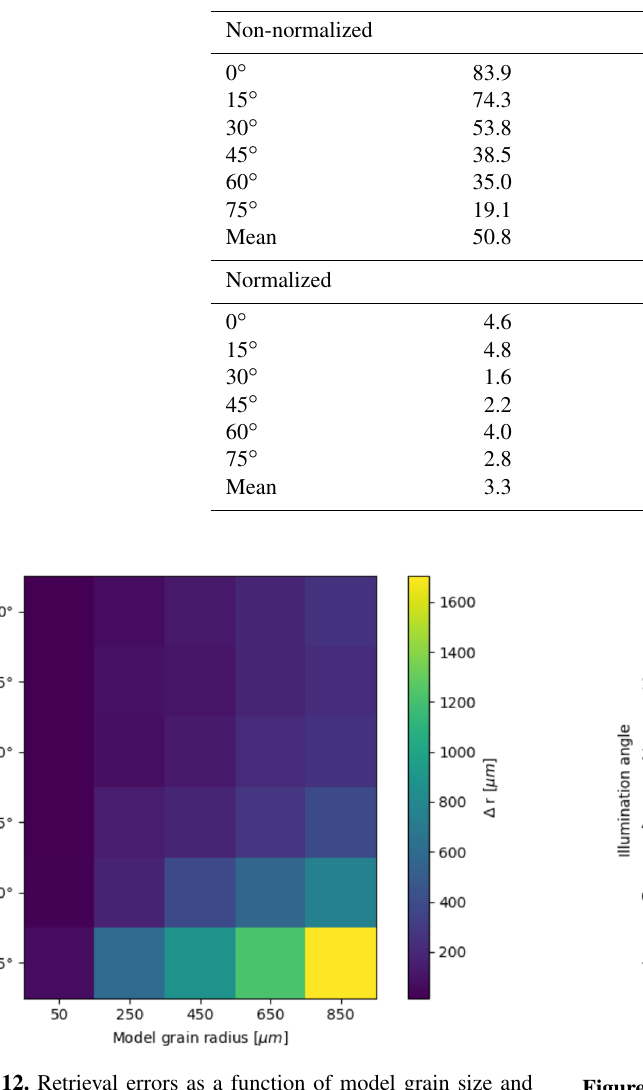
Table 1. Root mean square errors of retrieved snow grain size using non-normalized band area (top half) and normalized band area (bottom half). In the header, ”Calib.” refers to the reflectance quantity used to generate the lookup table, ”Retrieval” is the type of reflectance assumed to be measured, and ”Hemi. Mean” retains its meaning from Fig. 10 (i.e., hemispherically integrated spectral reflectance). θ 0 Calib.: Hemi. Mean